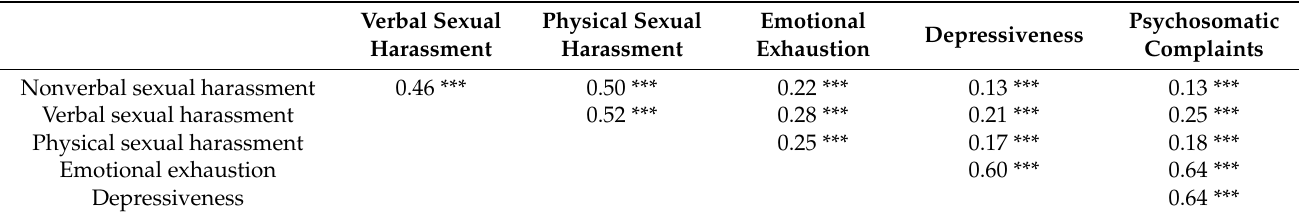
Table 4. Correlations between sexual harassment and impaired well-being. Verbal Sexual Physical Sexual Emotional Depressiveness Harassment Harassment Exhaustion